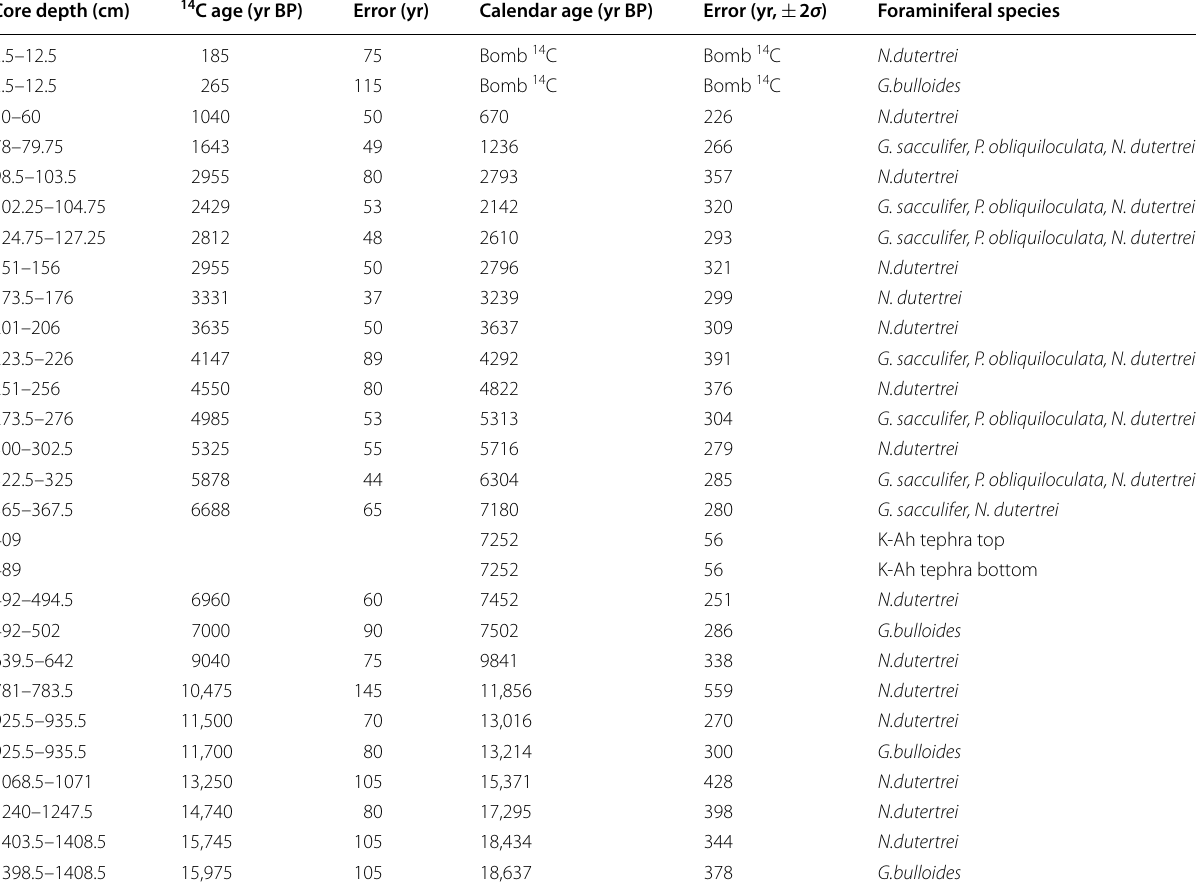
Table 1 Age control points of Core KY07-04 PC01 by radiocarbon ages of planktic foraminifera and K-Ah tephra chronology Core depth